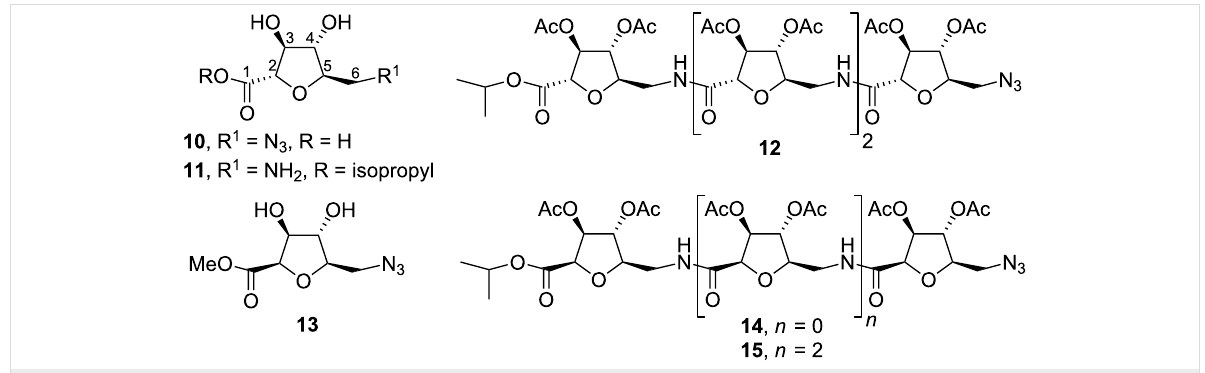
Figure 5: Short oligomeric chains of C -glycosyl D- arabino THF amino acid oligomers.